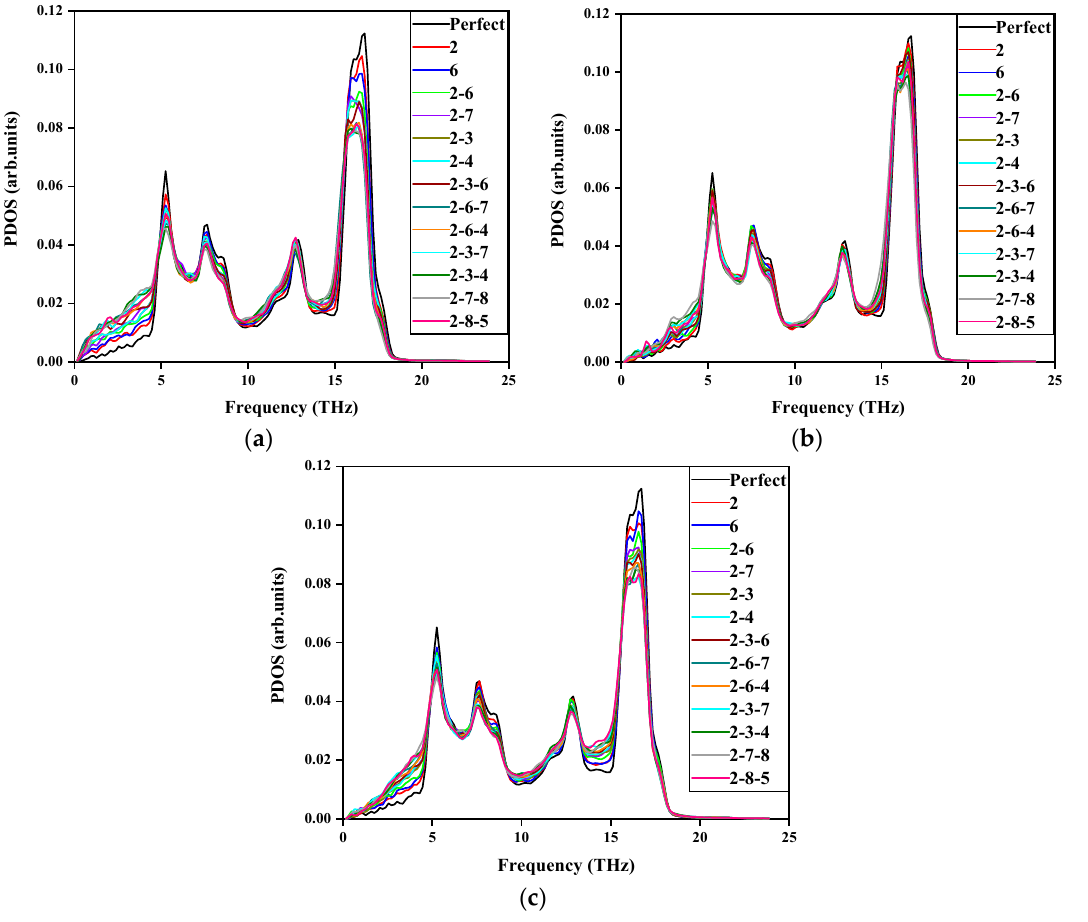
Figure 7. PDOS: ( a ) concave; ( b ) perforation; ( c ) amorphous. The numbers represent small block labels.